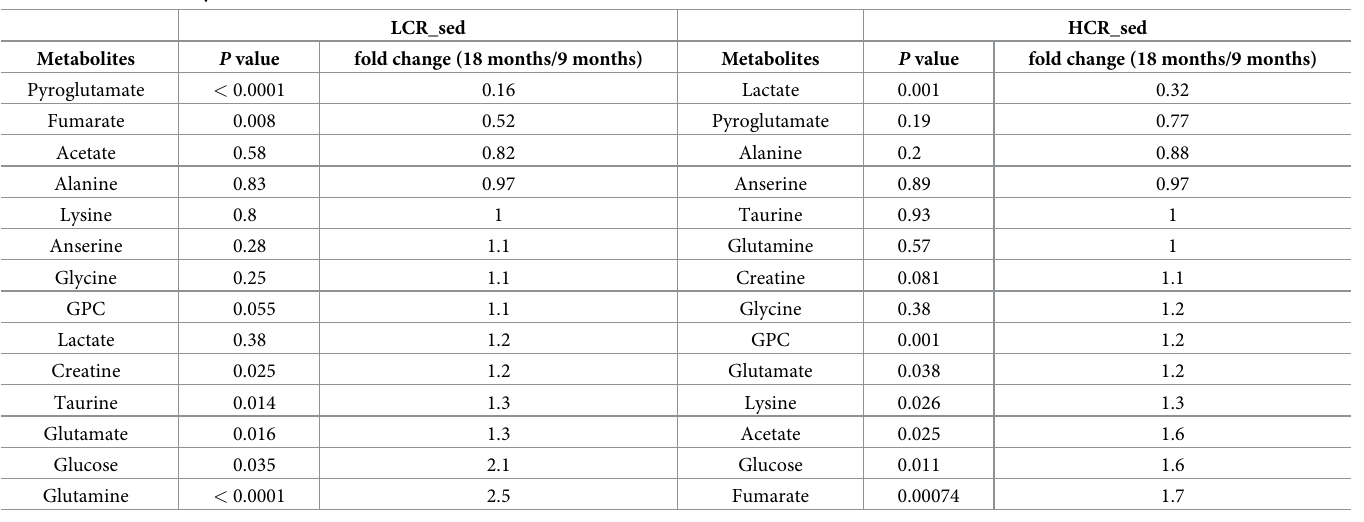
Table 4. Univariate analysis between 9 months and 18